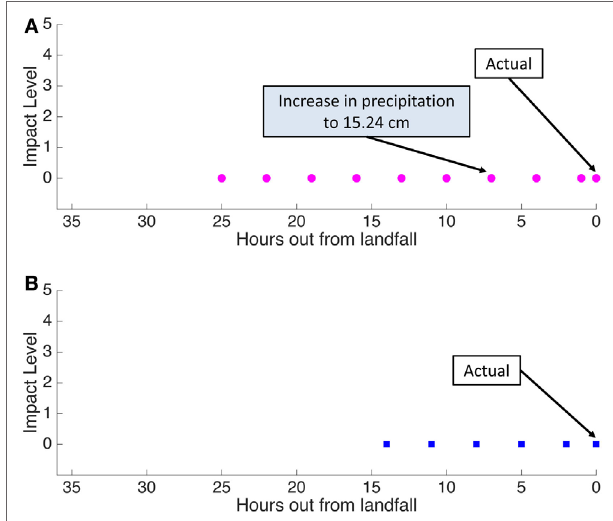
FigUre 6 | 2015 Hurricane Impact Level (HIL) Model forecasting results, with comparison to actual impact level, for (a) Tropical Storm Ana and (B) Tropical Storm Bill. Model confidence in forecast impact level shown in bold.